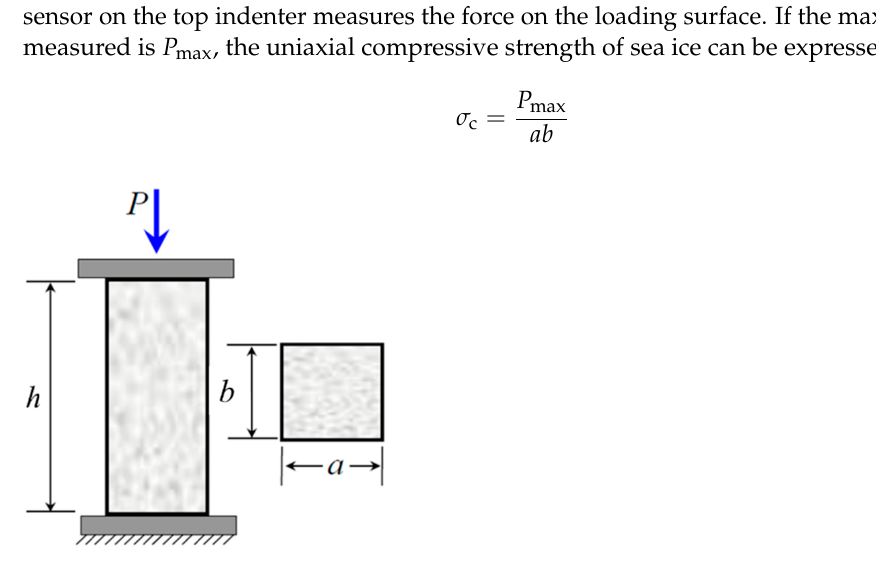
Figure 2. Sketch of the uniaxial compression test for sea ice. Table 1. Discrete element parameters in the simulation test of sea ice mechanics.